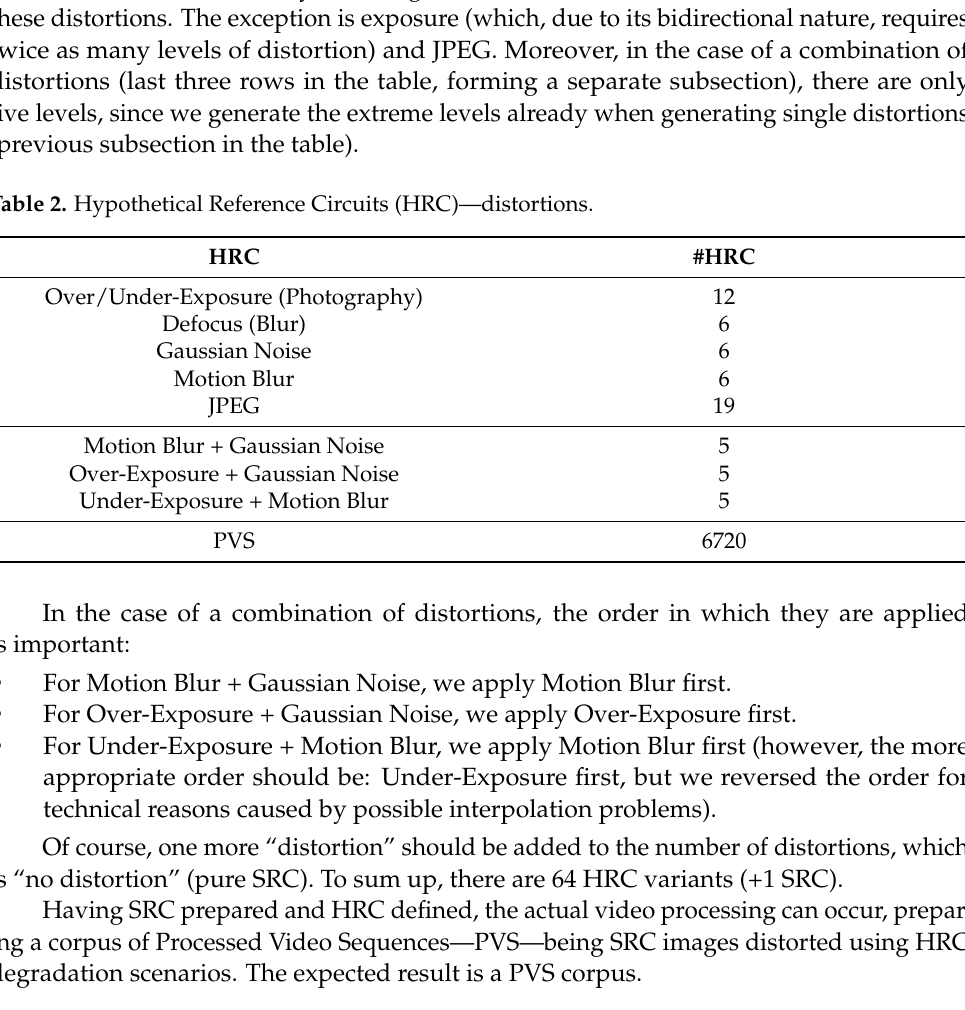
HRC Unit Min Max Under-Exposure FFmpeg filter parameter 0 − 0.6 Over-Exposure FFmpeg filter parameter 0 0.6 Defocus (Blur) ImageMagick filter parameter 0 6 Gaussian Noise FFmpeg filter parameter 0 48 Motion Blur ImageMagick filter parameter 0 JPEG ImageMagick filter parameter 0